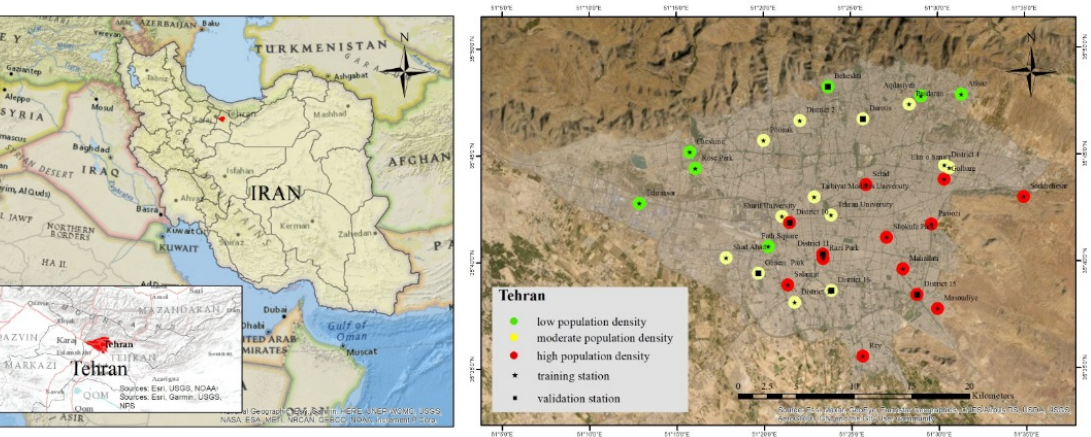
Figure 1. The study area (the Middle Eastern megacity of Tehran) in the left panel and the locations of 33 ambient NO (cid:2870) monitoring stations (26 training and seven validation stations) in the right